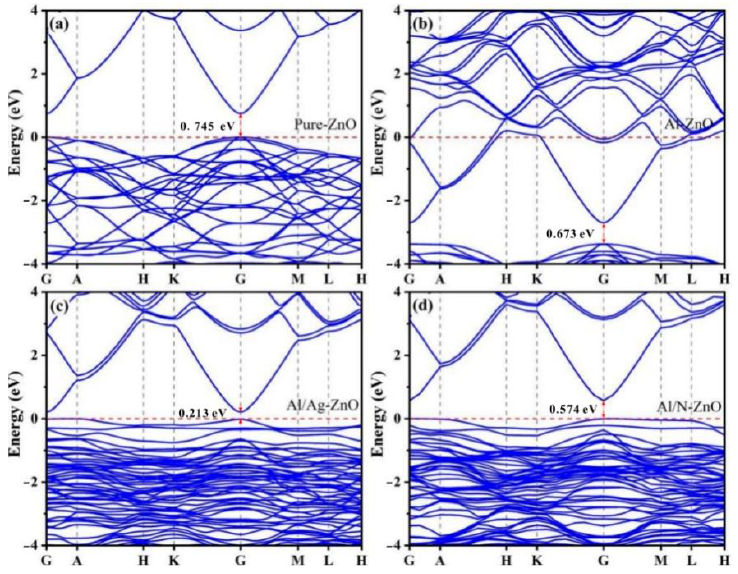
Figure 3. Band structures and band gaps of ZnO ( a ), metal single doping ZnO (Al-ZnO) ( b ), metal/metal co-doping ZnO (Al/Ag-ZnO) ( c ), and metal/non-metal co-doping ZnO (Al/N-ZnO) ( d ), respectively. The Fermi level is set to zero.